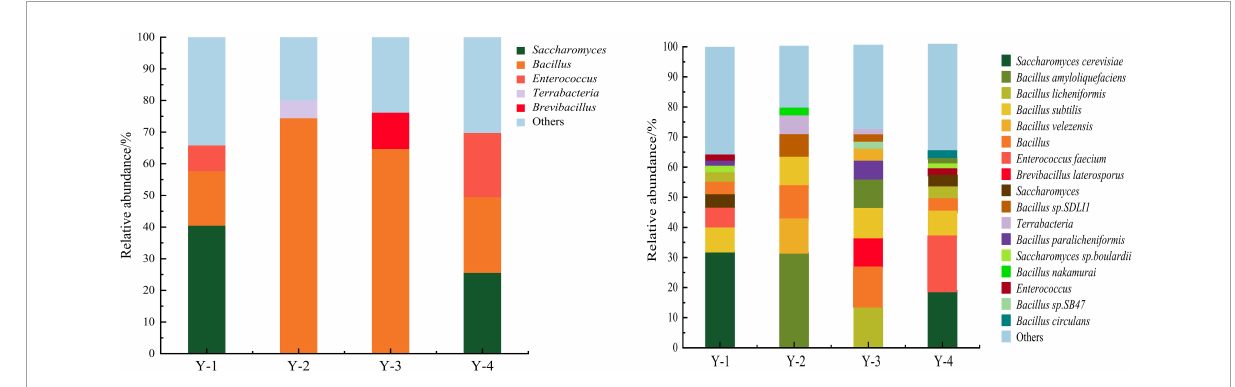
FIGURE1 Relative abundance of microorganisms at genus level (left) and species level (right) of four commercial microbial inoculants.